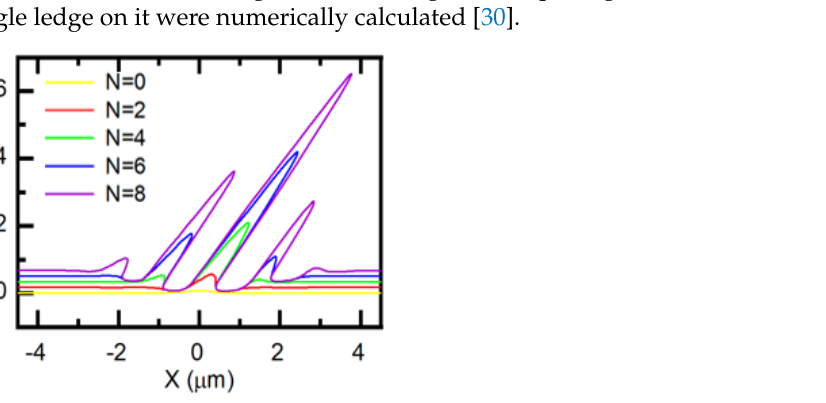
Figure 9. Computer simulation of shape evolution of a moving domain wall for switching by the series of rectangular field pulses. N is the number of pulses.